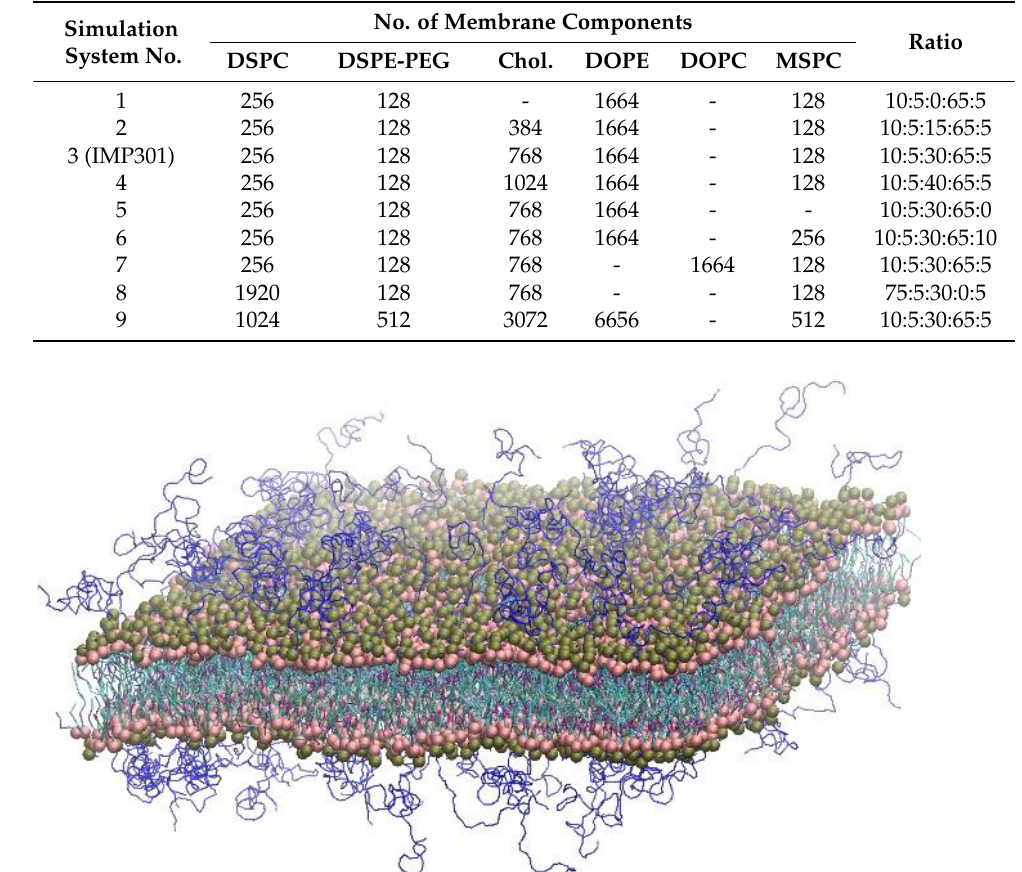
Figure 1. A snapshot of a IMP301 bilayer. Phosphate and choline (or ethanolamine) headgroups, hydrocarbon tails, PEG chains, and cholesterol are colored in pink, brown, light-blue, dark-blue, and purple, respectively. For clarity, water and ions are omitted. The images were created with Visual Molecular Dynamics [57].